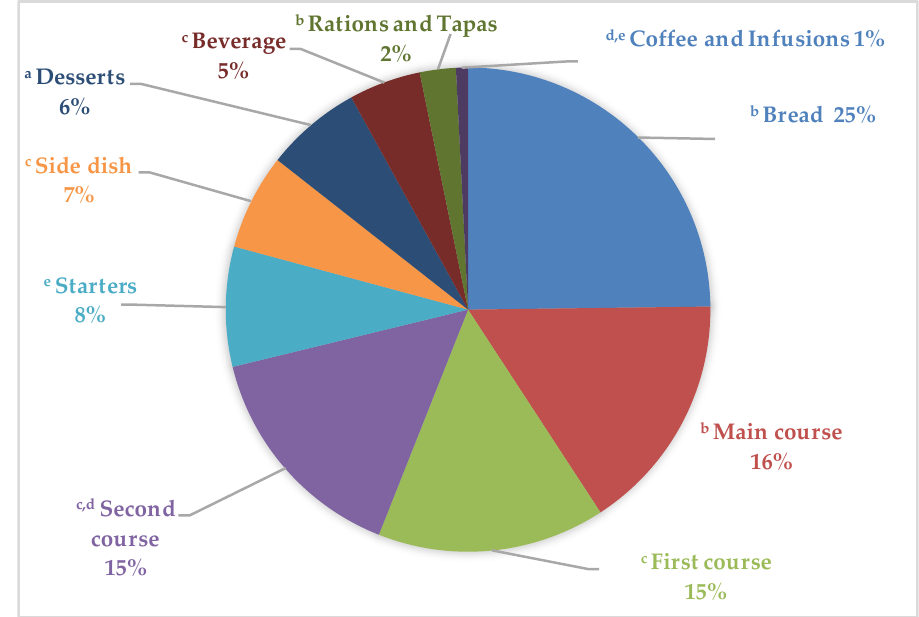
Figure 3. Distribution of plate waste across different menu components consumed by the ANIBES study population. Different superscript letters indicate statistically significant differences among groups ( p < 0.05, Student–Newman–Keuls test).